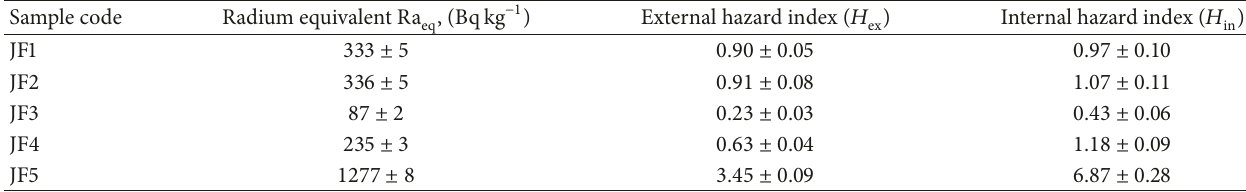
Figure 3: Comparison of absorbed and annual effective doses of Egyptian and Japanese fertilizers. Table 4: The Radium equivalent and hazard index in Japanese fertilizers.